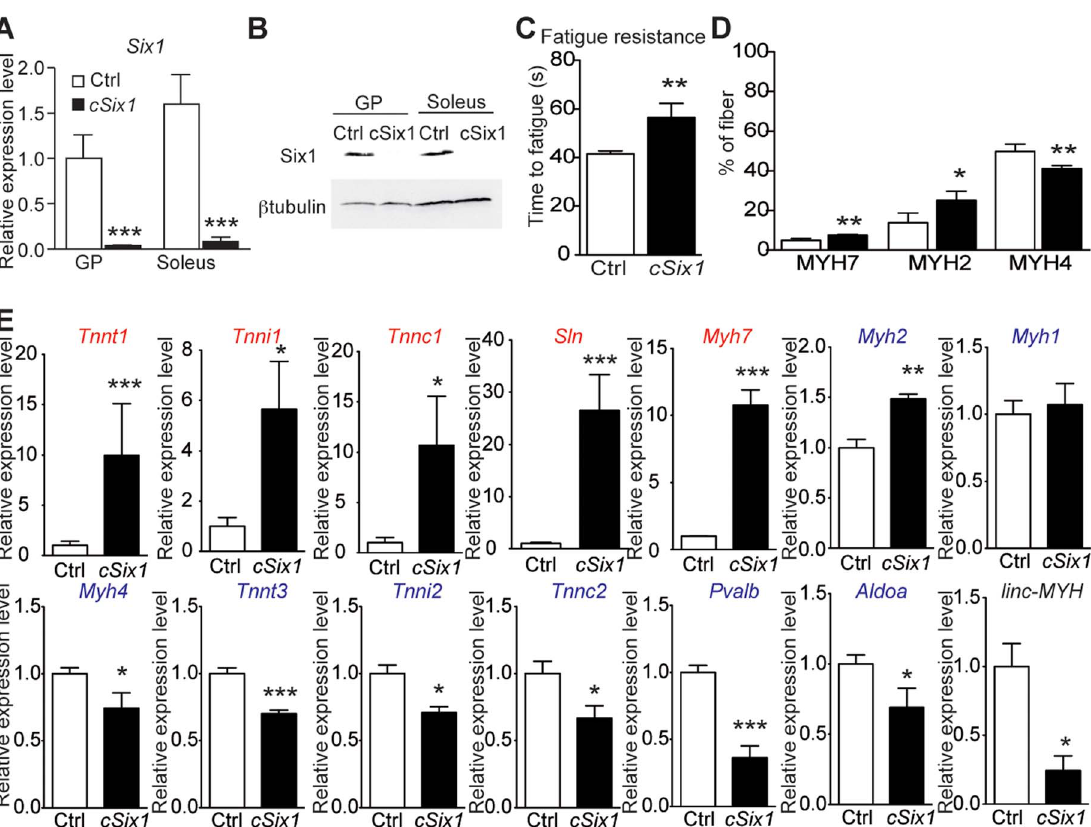
Figure 3. Six1 deficiency impairs the adult phenotype of fast muscle. (A) Six1 mRNA expression levels in GP and Sol muscles of three month- old control (Ctrl, n=4) and cSix1 KO (n=3) mice. (B) Western blot analysis of Six1 and b tubulin expression in Sol and GP of Ctrl and cSix1 KO mice. (C) Time to fatigue ratio of TA muscles of Ctrl (n=4) and cSix1 KO (n=4) mice. (D) Percentage of myofibers expressing MYH7, MYH2 and MYH4 in TA muscles of three month-old Ctrl (n=4) and cSix1 KO (n=4) mice. (E) mRNA expression levels of slow-type genes (red), fast-type genes (blue) and linc- MYH in TA muscles of three month-old Ctrl (n=4) and cSix1 KO (n=4) mice. *P , 0.05, **P , 0.01, ***P , 0.001.